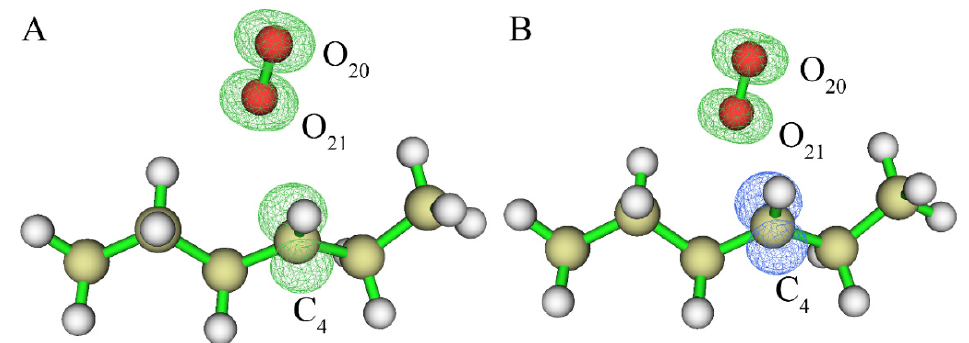
Figure 5. ( A ) The spin density of the minimum energy crossing point in the quadruple state; ( B ) the spin density of the minimum energy crossing point in the double state (the value of the iso-surface is 0.01).